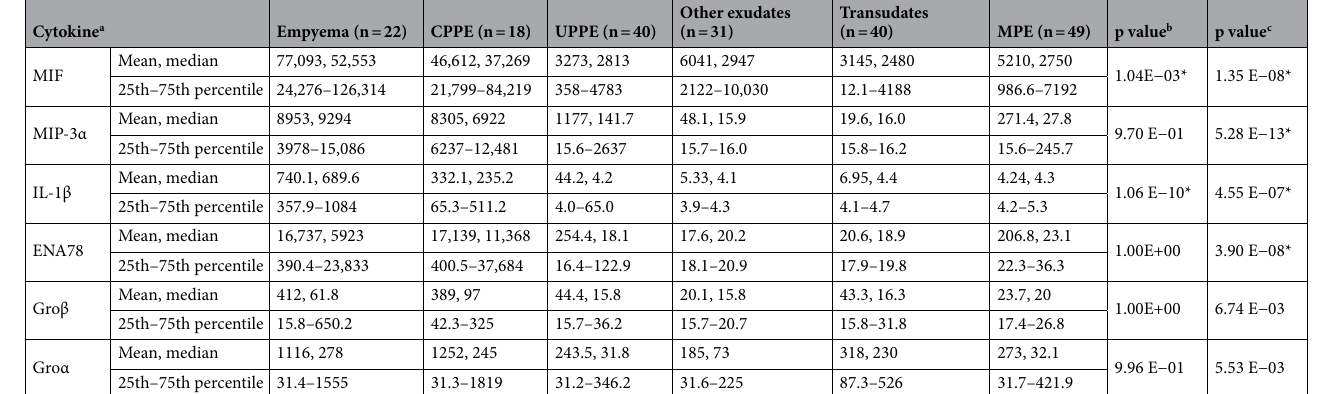
Table 4. Pleural effusion levels of six cytokines in six types of pleural effusion by ELISAs. a Data are presented as mean, median, and 25th–75th percentile (pg/ml). UPPE uncomplicated parapneumonic effusion, CPPE nonpurulent complicated parapneumonic effusion, MPE malignant pleural effusion. Statistical analysis was done using the post hoc Tukey test. Bonferroni-adjusted p-values < 0.05/30 (6 cytokines and 5 comparisons) = 0.00166 indicate significance between b empyema vs CPPE or c CPPE vs UPPE.